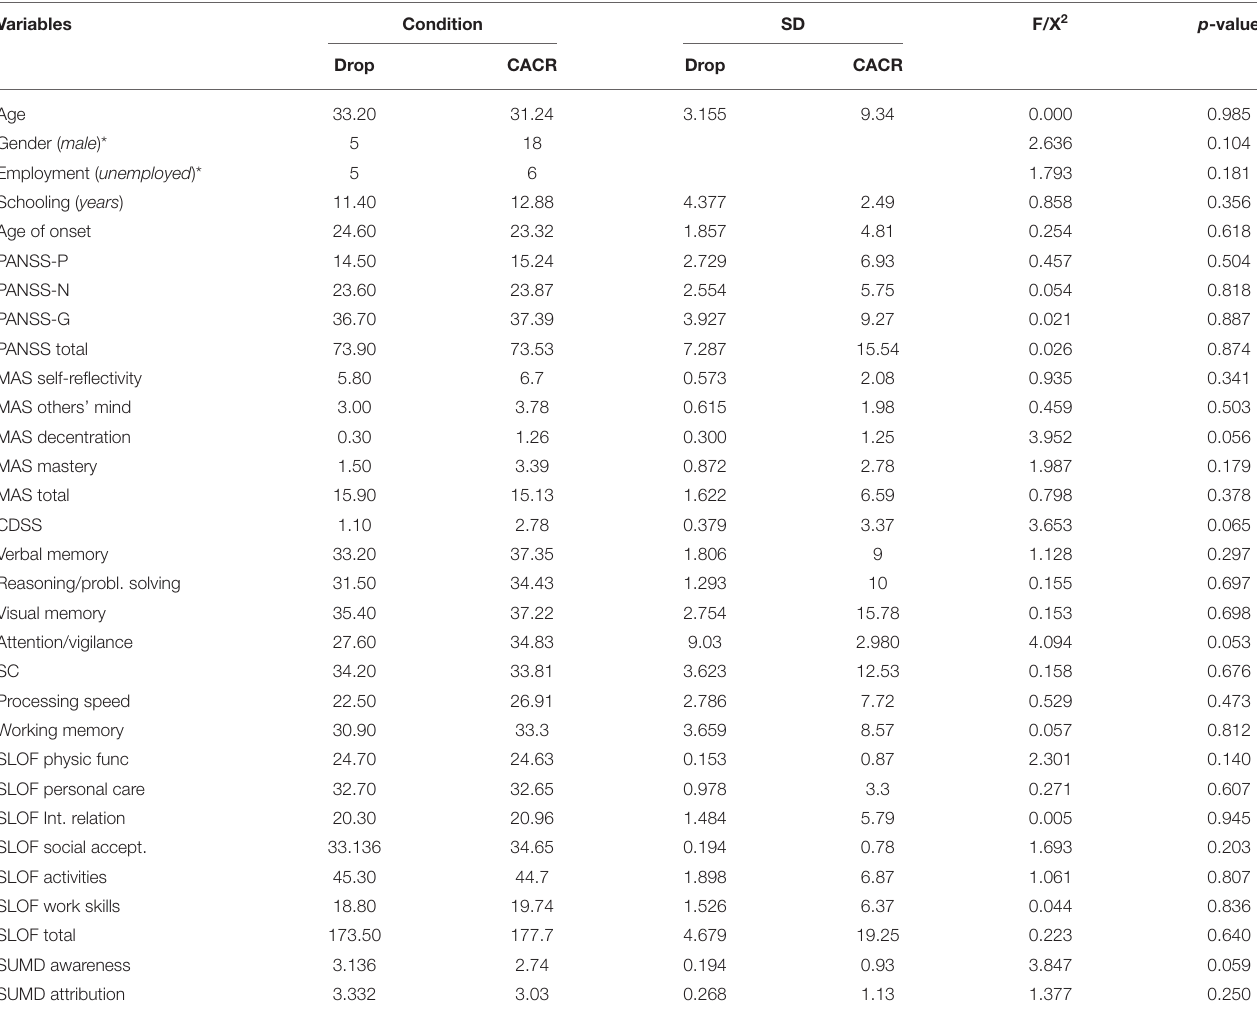
TABLE 2 | Differences between drop-outs and CACR group